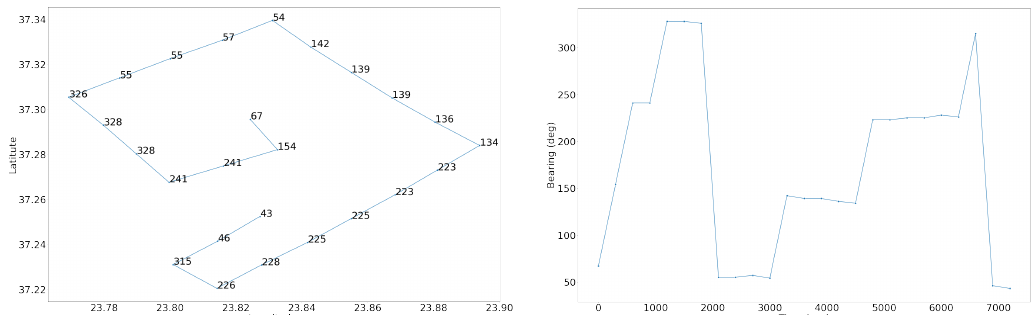
Figure 4. A synthetic expanding square maneuver in the 2-D space ( left ) and the respective shapelet of the vessel bearing ( right